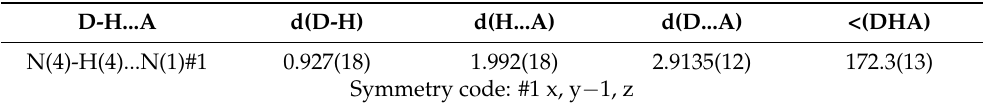
Table 3. Hydrogen bonds for 2 [Å and ◦